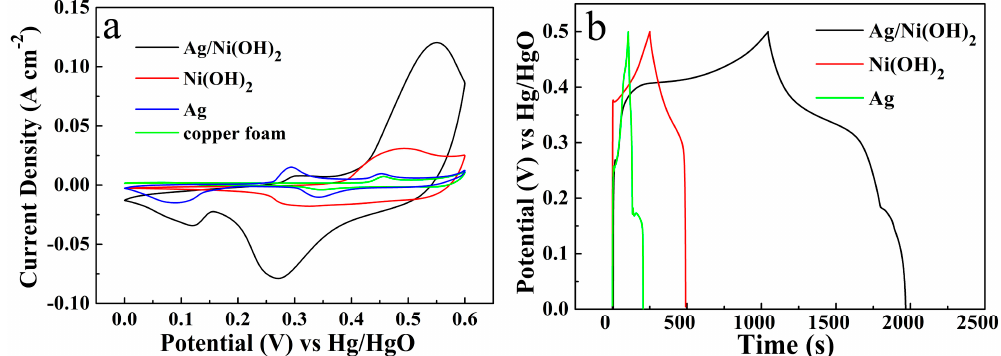
Figure 4. ( a ) CV curves of Ag/Ni(OH) 2 , Ni(OH) 2 , Ag electrode and copper foam substrate at a scan rate of 10 mV s − 1 ; ( b ) a comparison of GCD curves of the three electrode.